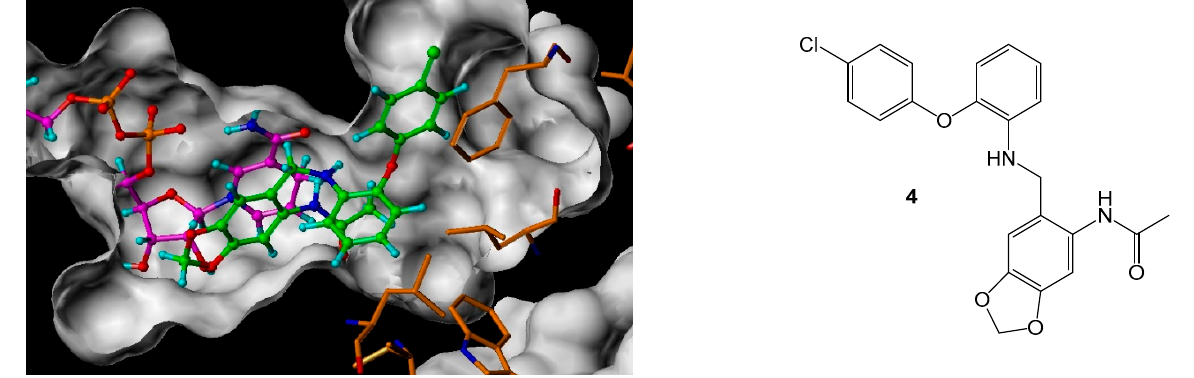
Figure 6. Compound 4 with a 4,5-methylenedioxy substituent docked into the homology model.